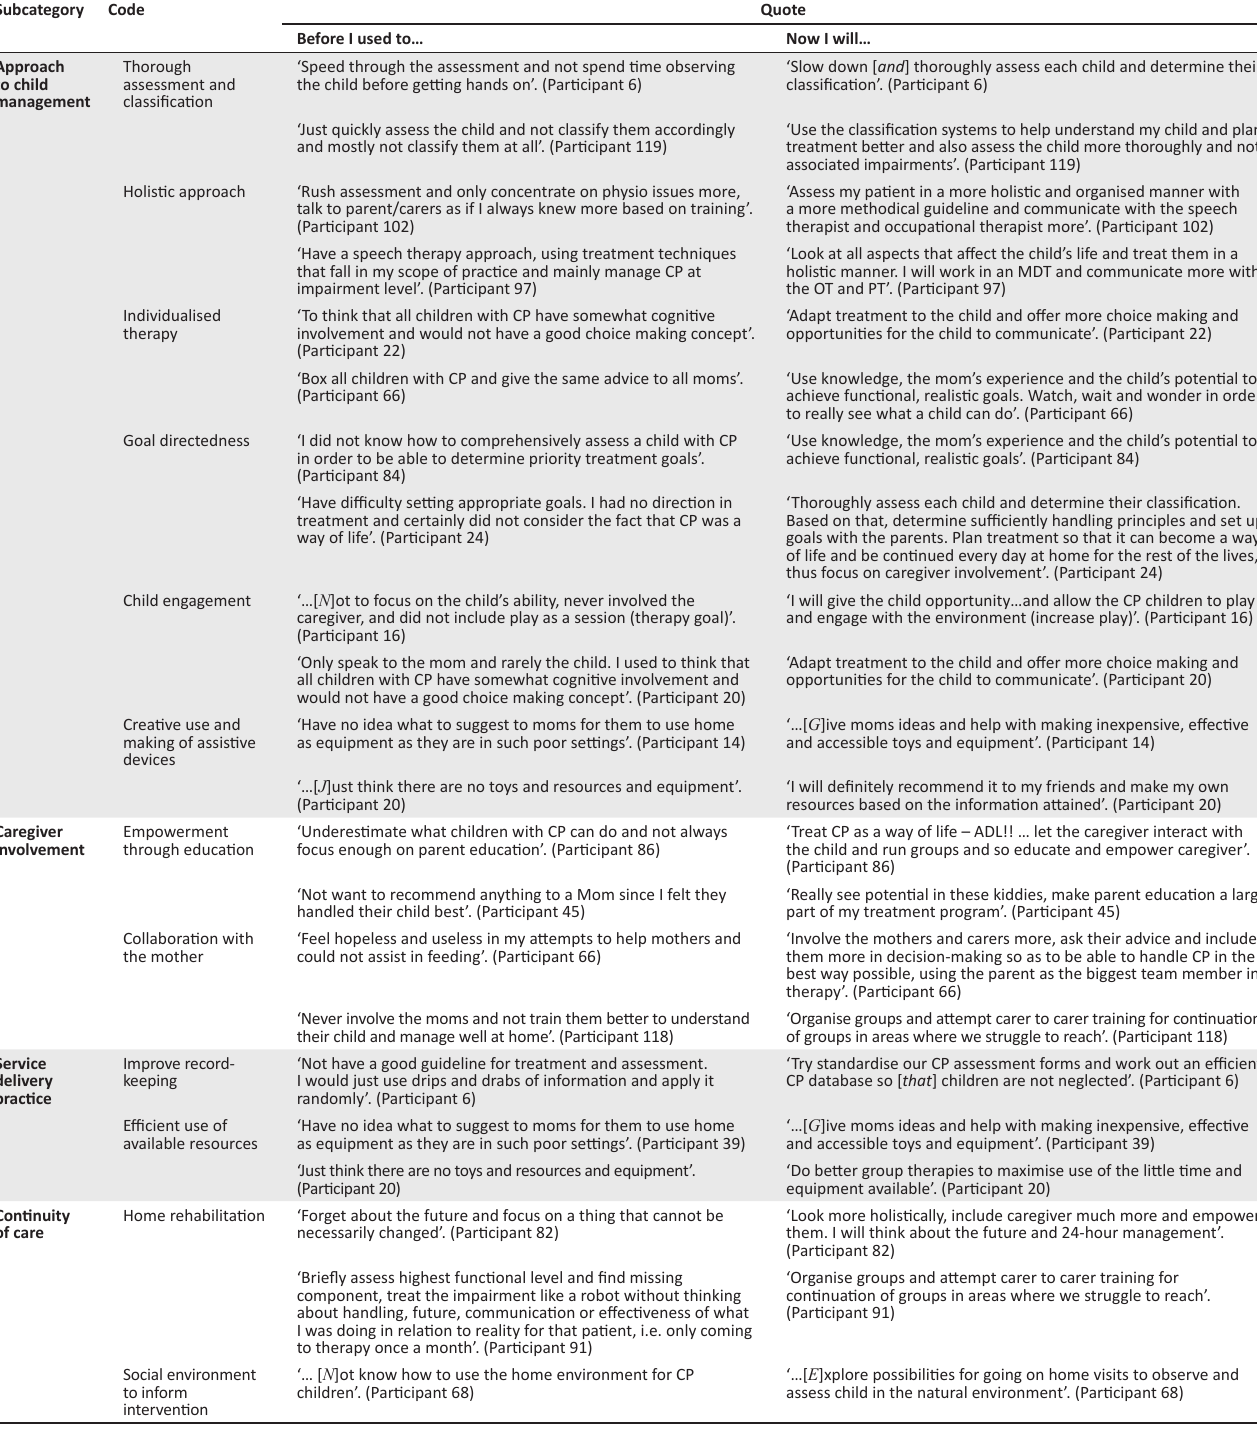
TABLE 5: Participants’ self-perceived change in clinical practice intention regarding cerebral palsy management. Subcategory Code Quote Before I used to… Now I